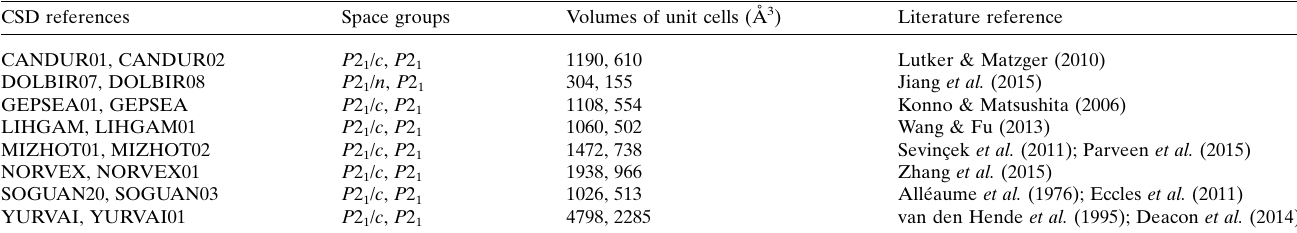
Table 2 Examples of dimorphic crystal structures with packing polymorphism in the symmetry class 2/ m